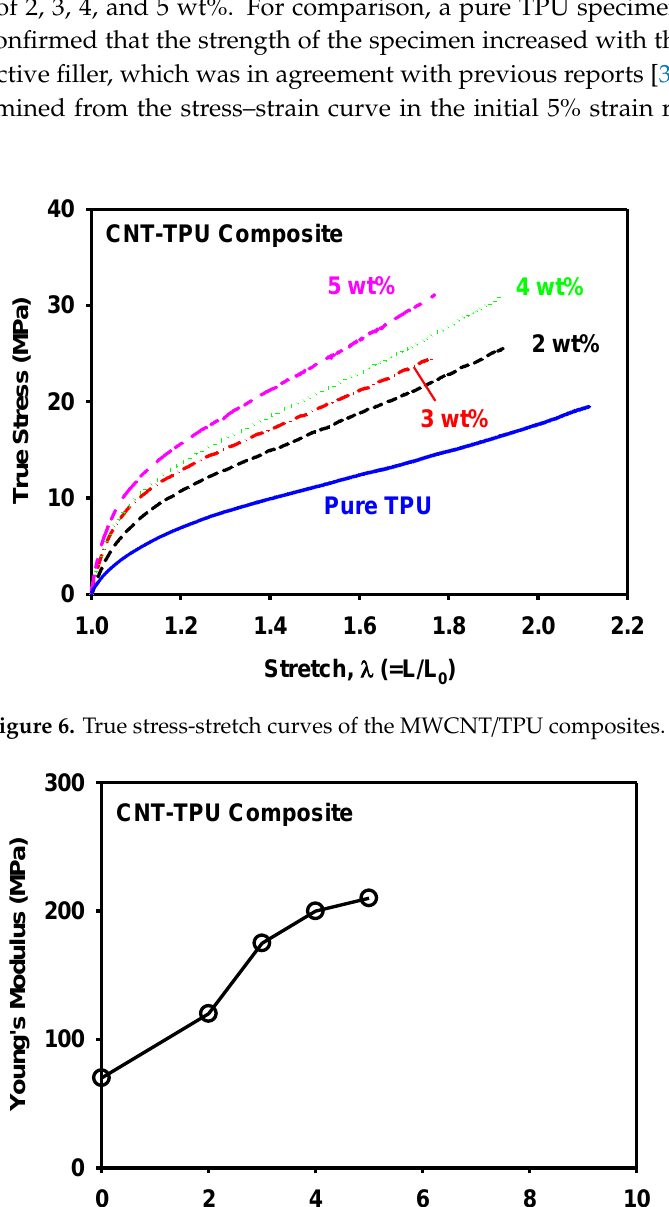
Figure 7. Young’s modulus of the 3D -printed MWCNT/TPU composites.